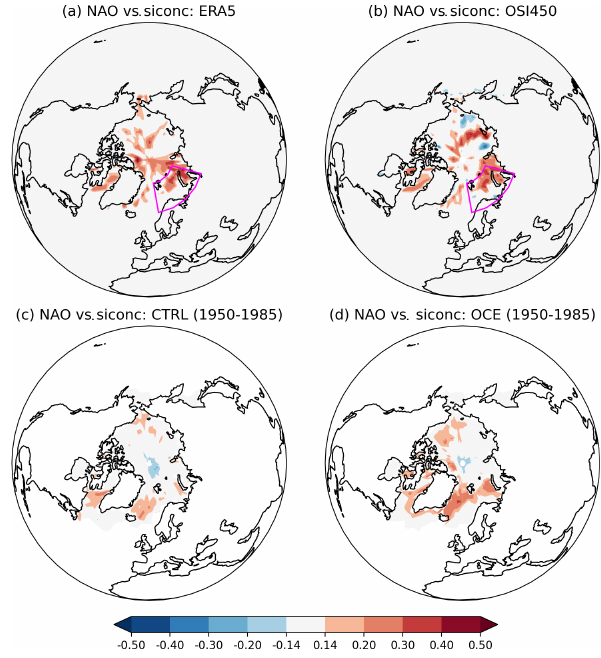
Figure B2. Correlations between the detrended November siconc anomalies at each grid point and the DJF NAO time series. In (a) ERA5 (1980–2015), (b) OSI450 (1980–2015), (c) CTRL (1950– 1985), and (d) OCE (1950–1985). The ensemble members of the CTRL and OCE experiments have all been concatenated together. For the CTRL and OCE plots (c) and (d) , every grid point outside the zero contour is statistically significant ( p < 0 . 05). For ERA5 and OSI450, only grid points in the Barents and Kara seas are sig- nificant. In (a) and (b) the Barents–Kara region has been marked by a purple